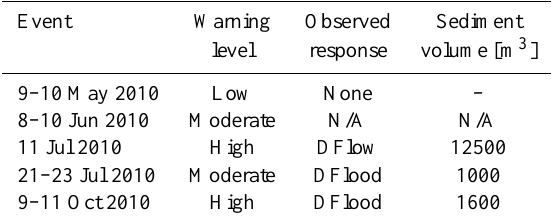
Table 3. Summary of the results obtained in the Rebaixader sub- basin for the events presented in Sect. 4.2; “DFlow” and “DFlood” stand for “debris flow” and “debris flood”,